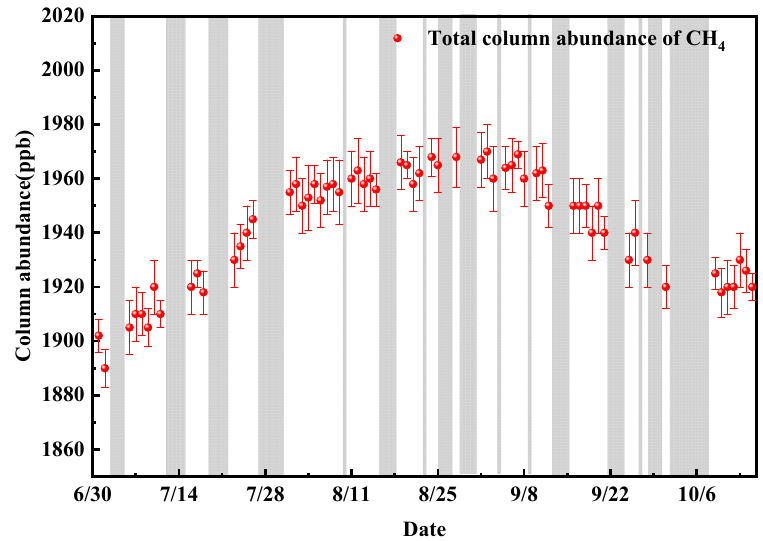
Figure 6. Time series of the CH 4 retrieval results. Estimations of 95% confidence ranges are indi-